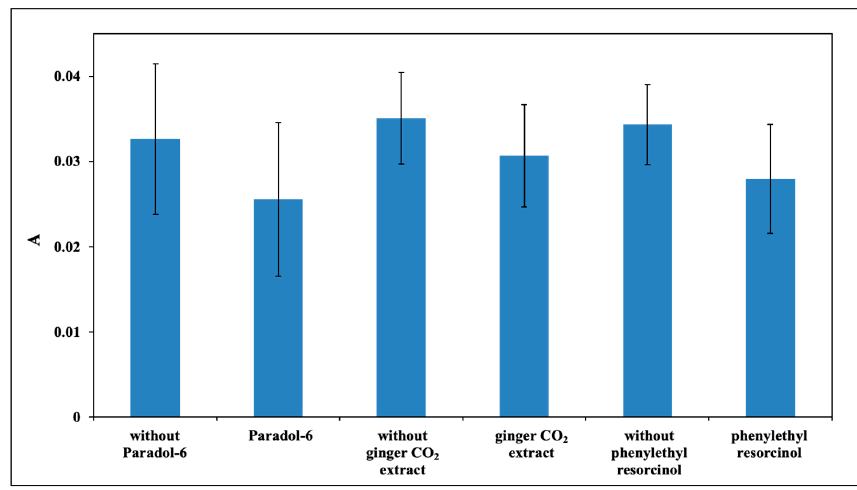
Figure 2. Absorbance at 600 nm of DHI photoirradiation mixture containing 1 µ M RF with or without selected CI (paradol-6, ginger CO 2 extract, phenylethyl resorcinol) after 1 h.